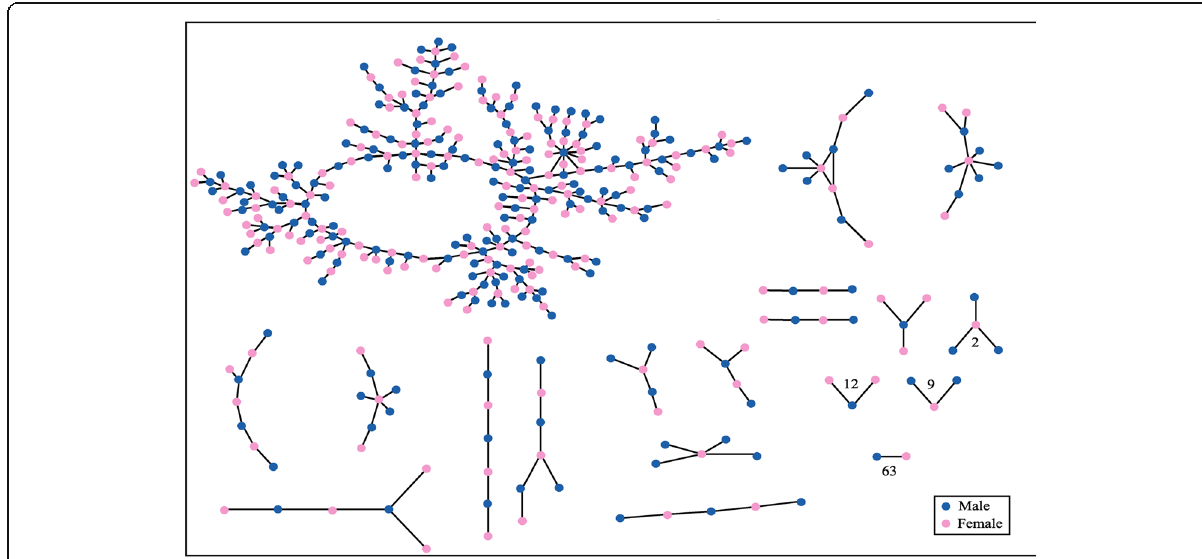
Fig. 2 The structure of romantic and sexual relationships of high school students, whereby each circle represents a student and the lines connecting the students represent the romantic relationships which took place at any point during the 6 months preceding the interview (Bearman et al.,